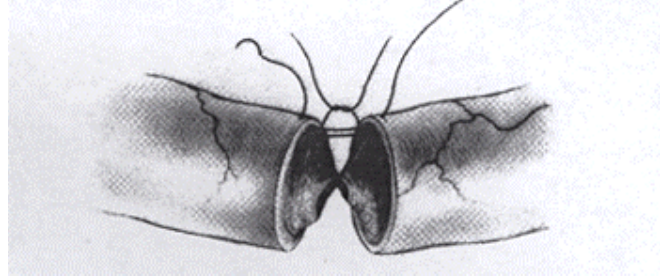
FIGURE 6 . Two 8-0 sutures initiating an outer layer of a formal two-layer